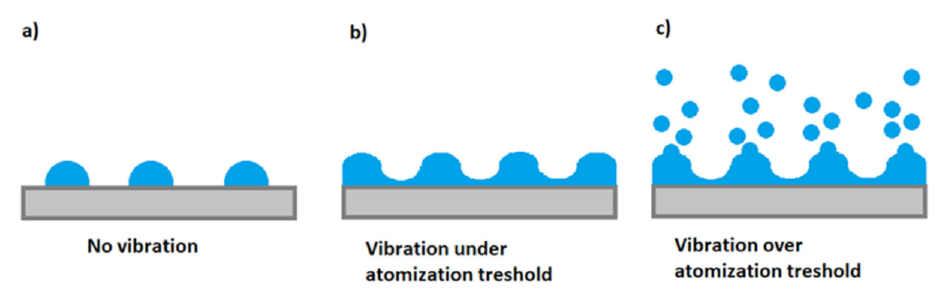
Figure 1. Ultrasonic atomization cases: ( a ) no vibration, ( b ) vibration under the atomization threshold (no atomization occurs), and ( c ) atomization.